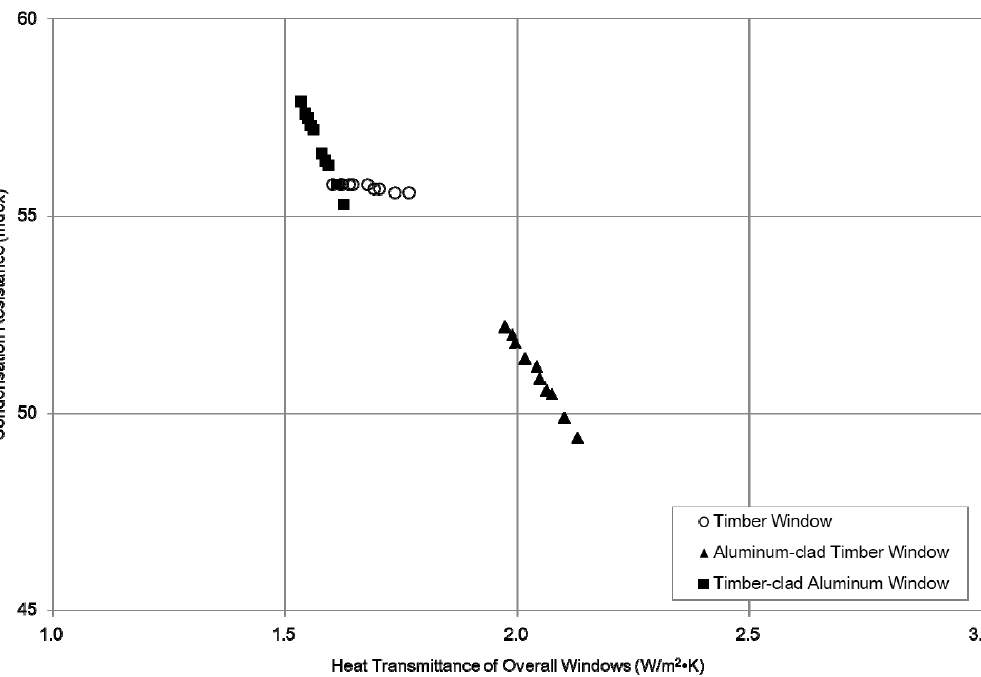
Figure 9. Correlation analysis for heat transmittance and condensation resistance of timber windows with changes in wood species and anatomical direction.